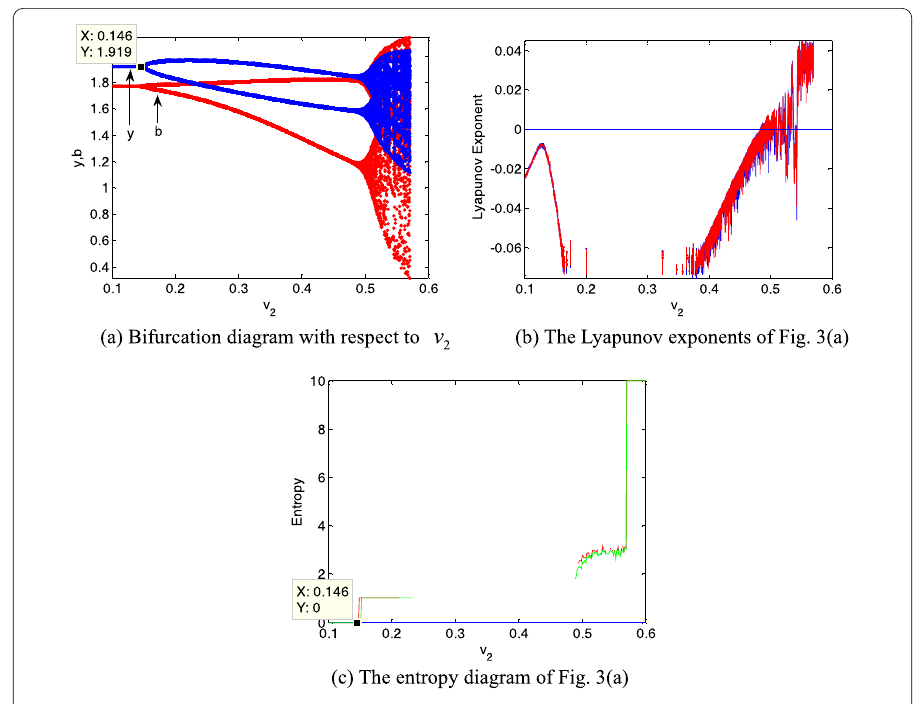
Figure 3 Dynamic evolution of decision variables with v